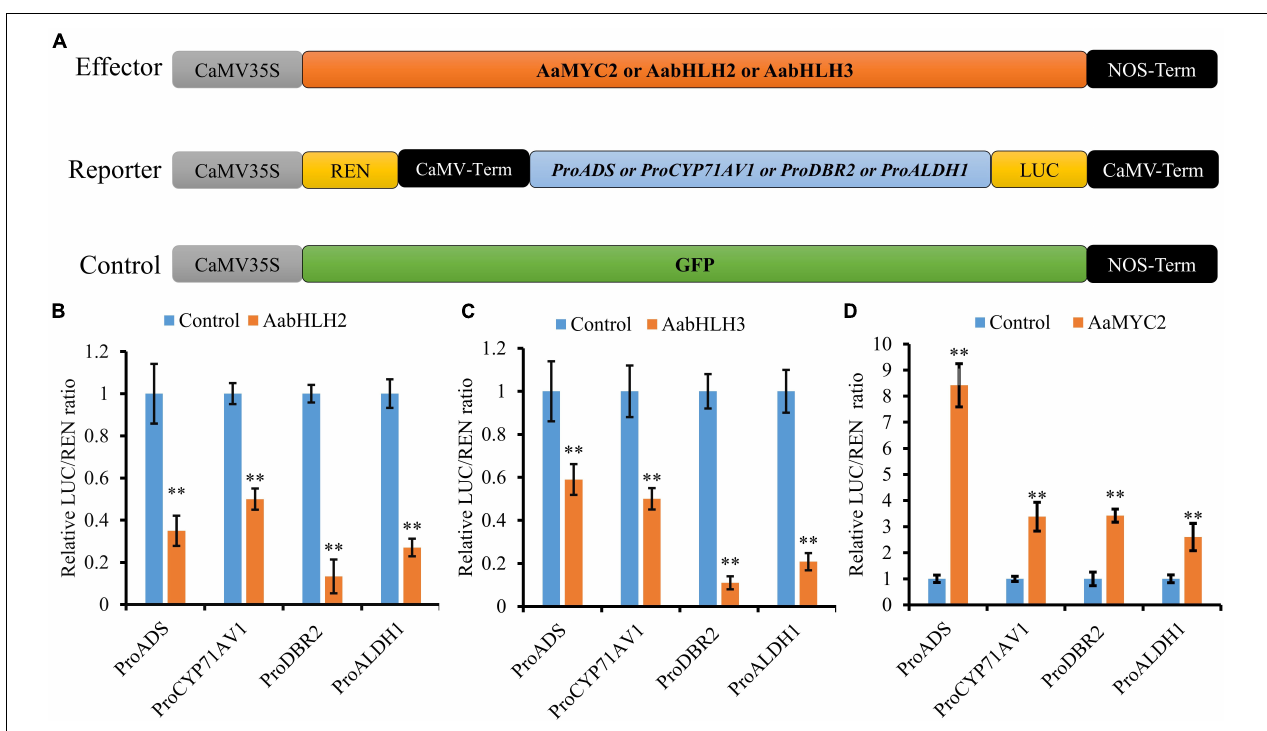
FIGURE 2 | AabHLH2 and AabHLH3 regulate artemisinin biosynthetic genes expression as transcriptional repressors. (A) Schematic representation of effector and reporter constructs used in the Dual-LUC assays; (B,C) Transient Dual-LUC analysis of AabHLH2 and AabHLH3 with four artemisinin biosynthesis specific pathway gene promoters. (D) Transient Dual-LUC analysis of AaMYC2 (positive control) with four artemisinin biosynthesis specific pathway gene promoters; The values were reached by calculating the relative ratio of LUC activities to REN activities (LUC/REN) and the GFP control was set to one. Data are means ± SD ( n = 4). Student’s t -test: ∗ , P < 0.05; ∗∗ , P <